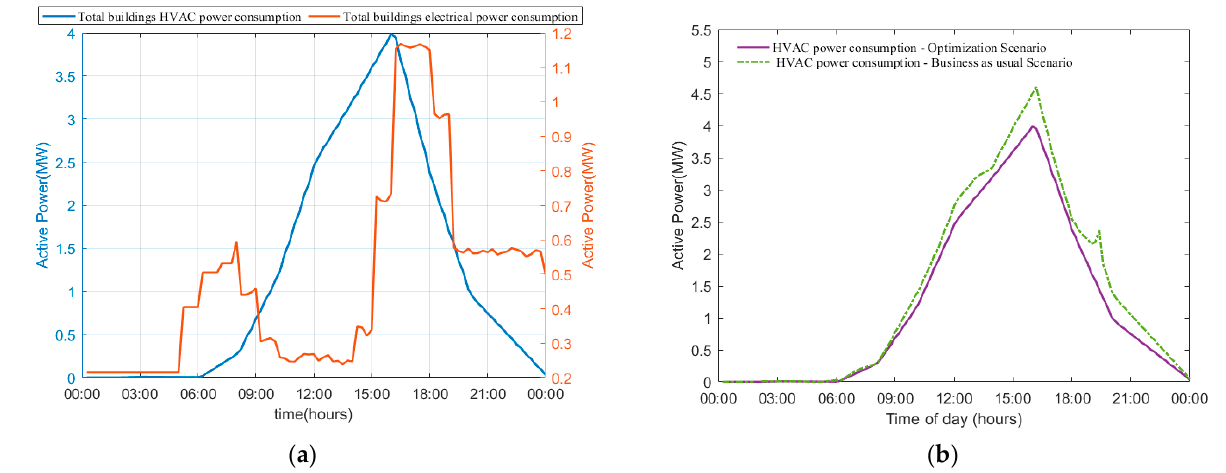
Figure 10. Total buildings’ HVAC and electrical power consumption. ( a ) Optimal operation. ( b ) Typical operation.